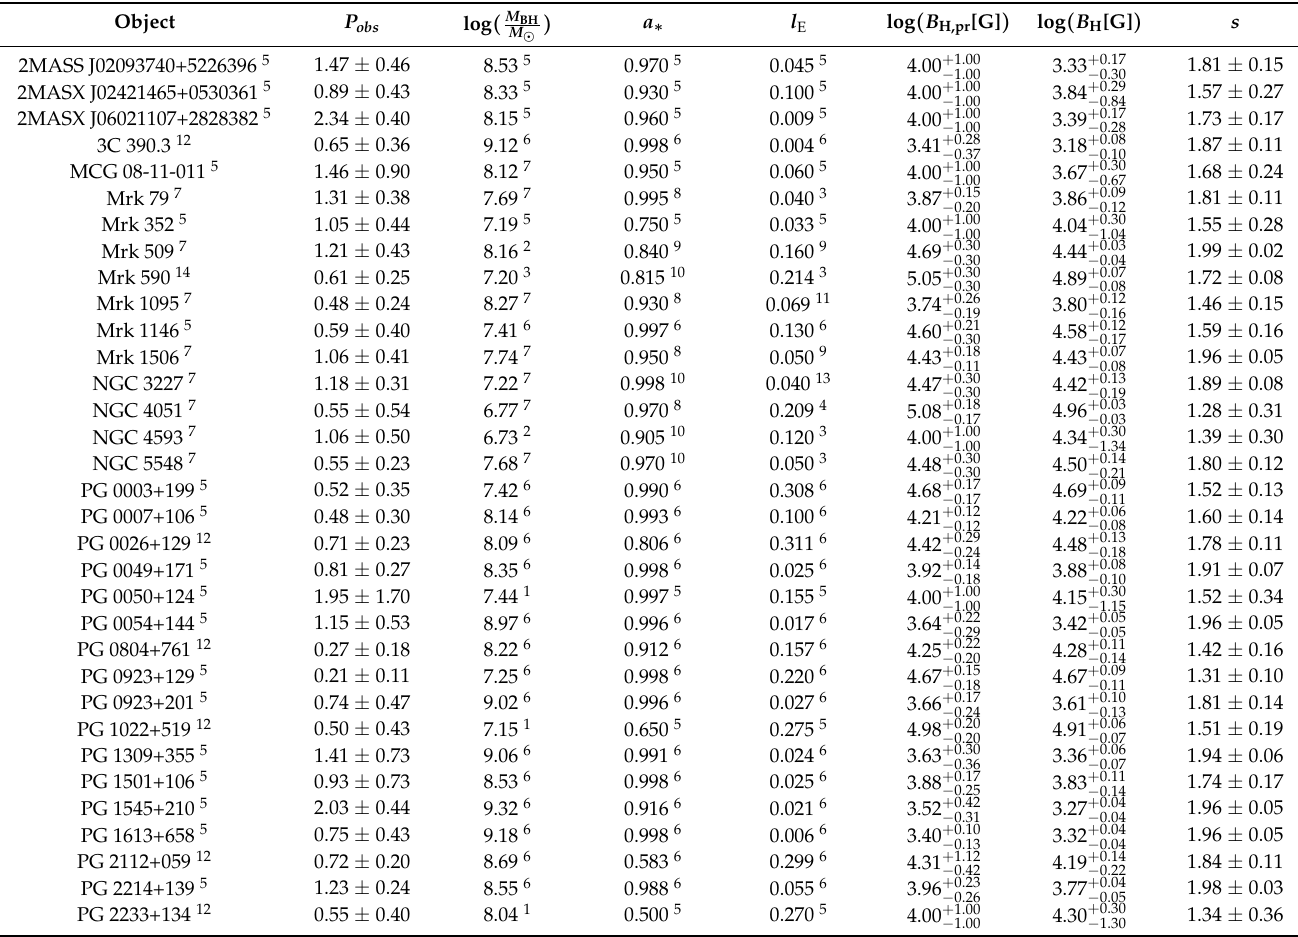
Table 2. Results of determination of the magnetic field intensity at the event horizon B H and parameter s for our objects. P obs is the observed polarization. M BH , a and l E are mass, spin and Eddington ratio of SMBH. B H,pr is magnetic field at the event horizon estimated by the method described in Piotrovich et al. [37], except for objects Mkn 509, NGC 3227, NGC 5548 and Mkn 590 whose magnetic fields were estimated in Daly [38]. For objects for which the magnetic field was not previously estimated, we took the value 4.0 ±